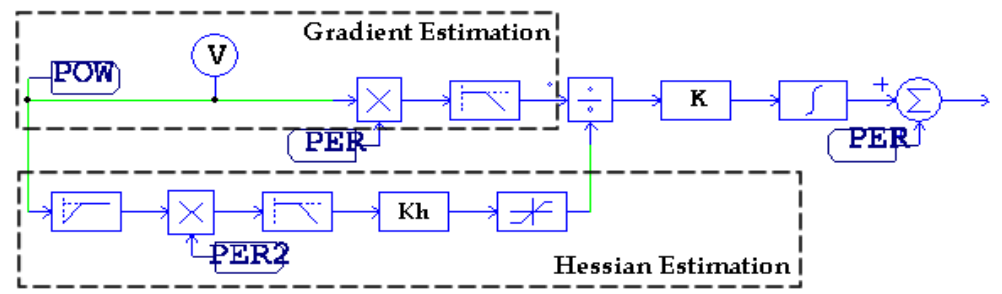
Figure 5. PSIM Schematic of MPPT circuit based on NL-ESC.